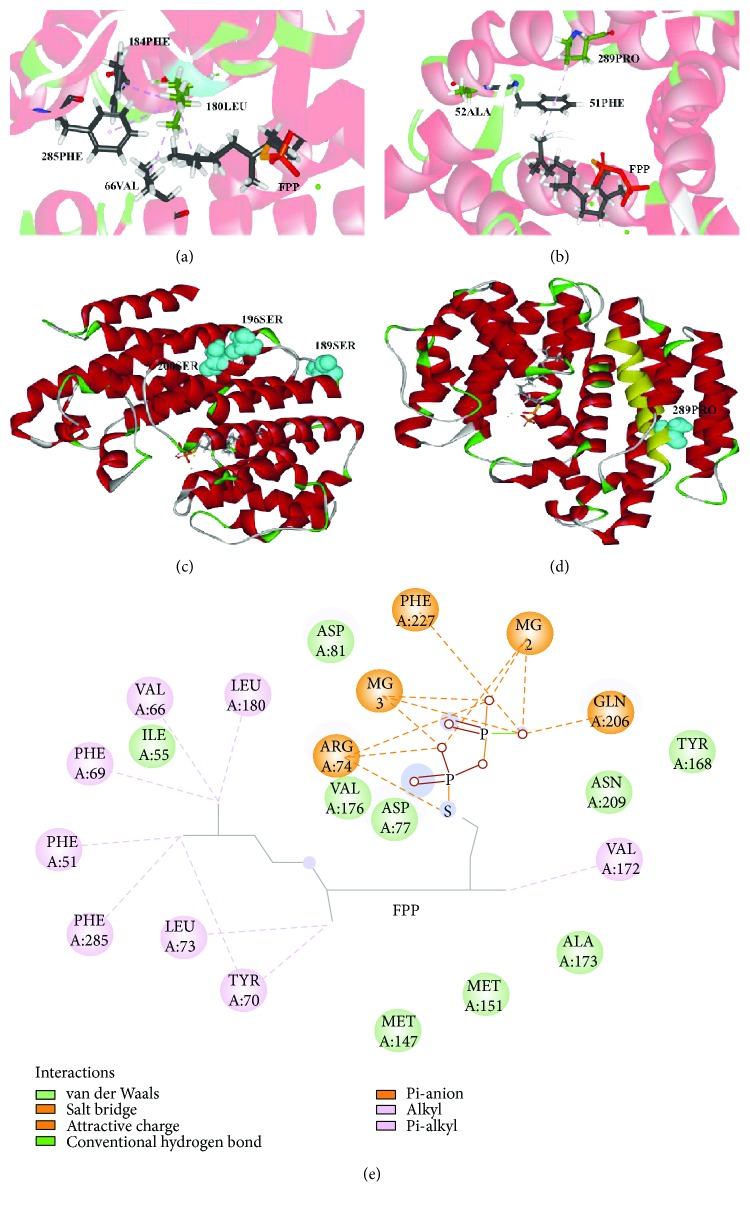
Sites of positive selection (52A, 180L, 189S, 196S, 200S, and 289P) on the GpSS model using DSV. (a) 180Leu was connected with FPP, 66Val, 184Phe, and 285Phe by nonbonded interactions. (b) 52Ala and 289Pro were connected with FPP and 51Phe. (c, d) Distribution of 189Ser, 196Ser, and 200Ser and 289Pro on the GpSS 3D structure. Yellow areas indicate transmembrane domains. (e) Relationship between GpSS receptors and ligands (FPP). Dashed lines indicate nonbonded interactions.